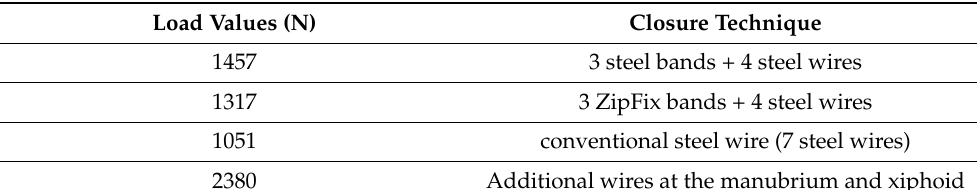
Table 7. The load values required for different sternal closure techniques to reach a rupture displace- ment of 2.0 mm